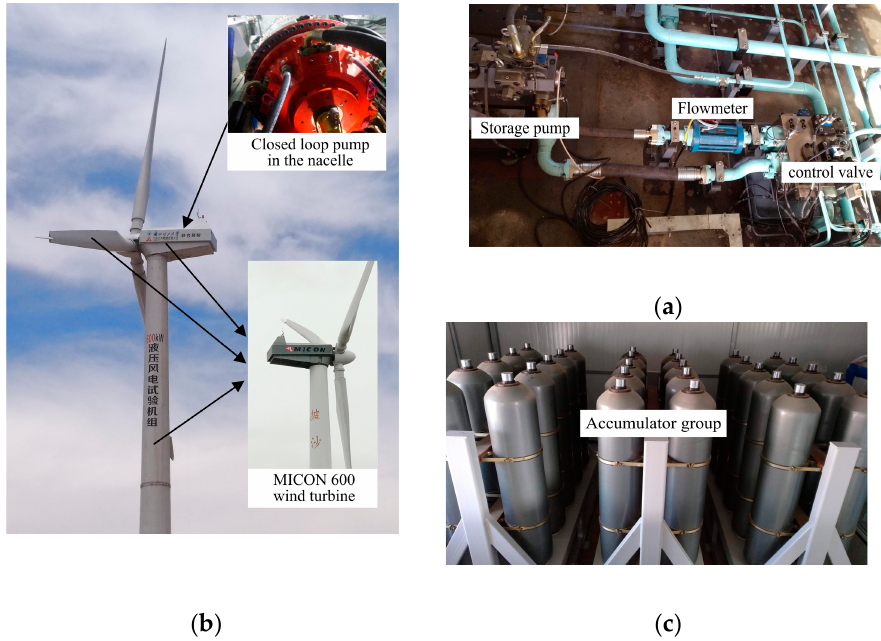
Figure 9. The 600 kW storage type wind turbine experimental platform: ( a ) The storage pump; ( b ) The Micon 600 kW wind turbine and closed loop pump; ( c ) The hydraulic accumulator group. Table 1. The parameters of the Micon 600 wind turbine.